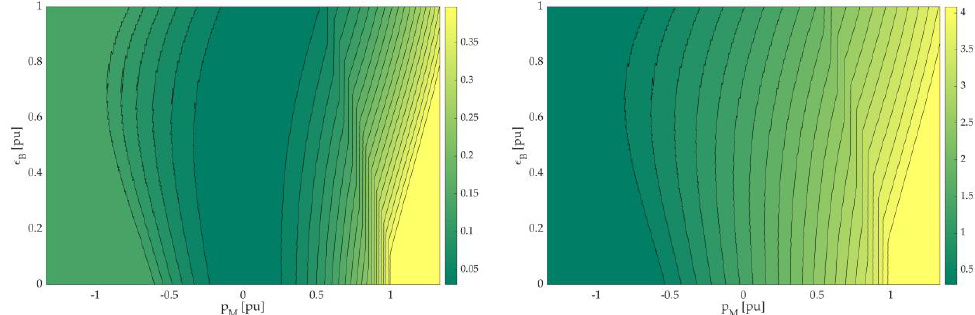
Figure 6. The optimal φ FC ( left ) and φ H2 ( right ) loci (in $/h) on the ( p M , ε B ) plane.